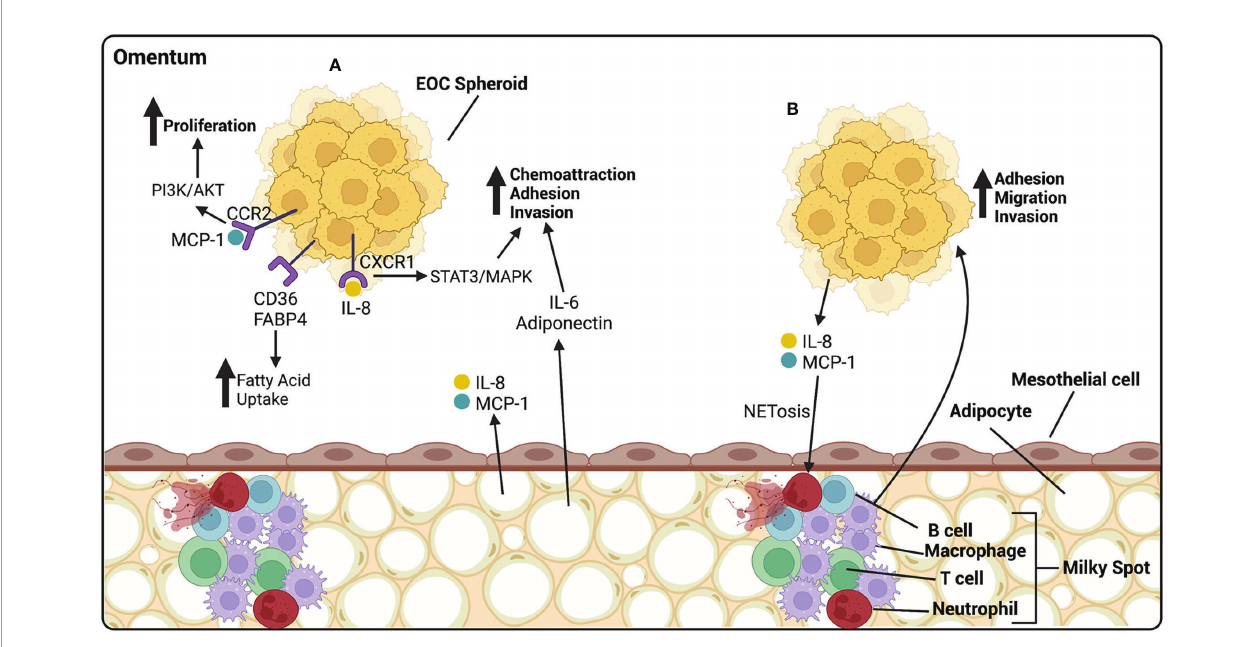
FIGURE 4 | EOC metastasize preferentially to the omentum, composed of mesothelial cells atop of adipocytes. (A) Adipocytes release cytokines and chemokines that in fl uence the progression of EOC. IL-6 and adiponectin act as chemoattractants, homing HGSOC spheroids to the omentum, and increasing their ability to adhere and invade. IL-8, released by adipocytes, binds CXCR1 on EOC cells, activating the STAT3/MAPK pathway and increasing adhesion and invasion of EOC cells. MCP-1, released by adipocytes, binds CCR2 on EOC cells, activating the PI3k/AKT pathway, increasing proliferation. CD36 and FABP4 receptors on EOC cells are involved in the uptake of fatty acids that can be utilized by the cancer cells as a source of energy. (B) Milky spots are highly vascularized areas, rich in immune cells. They are primarily composed of macrophages with a lesser proportion of T cells, B cells and neutrophils. EOC cells release IL-8 and MCP-1 that cause NETosis of neutrophils, to which cancer cells preferentially bind. Macrophages release many cytokines aiding in the adhesion, migration and invasion of HGSOC spheroids. Created with